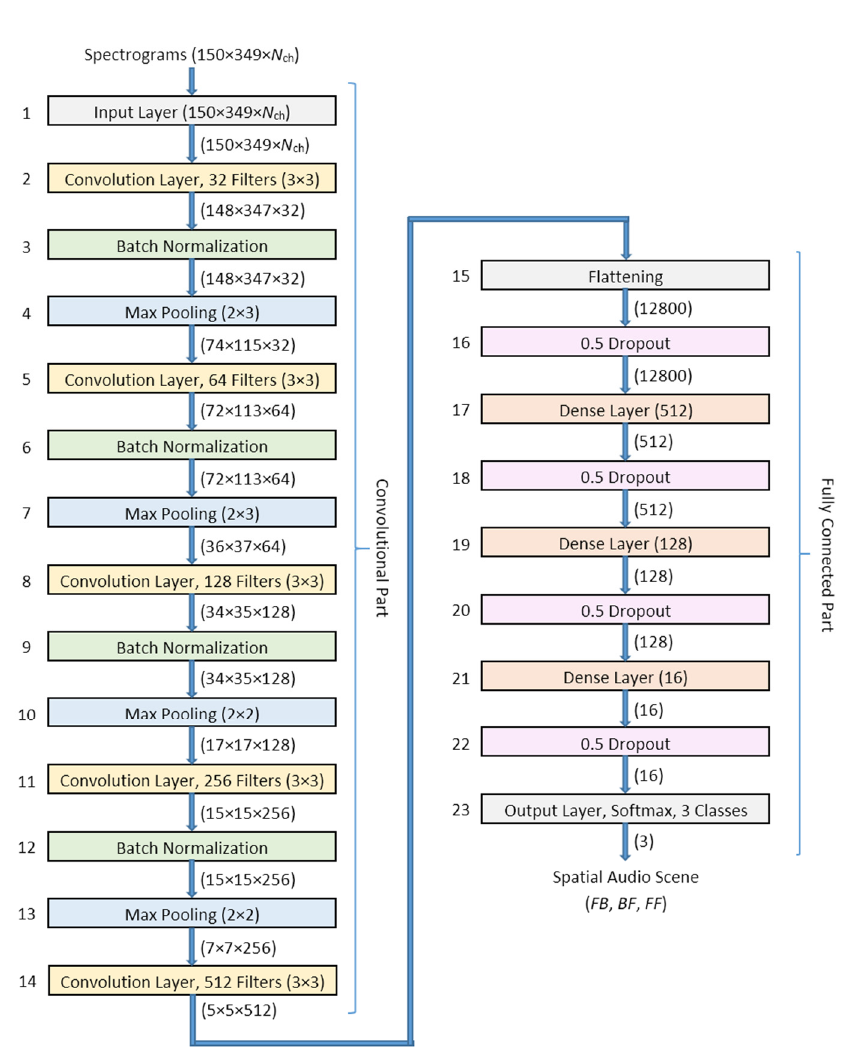
Figure 5. Topology of the convolutional neural network used for the spatial audio scene classification.